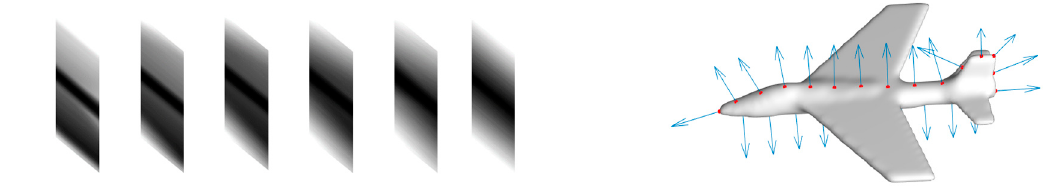
Figure 6. ( a ) Example of six consecutive frames of the tactile video captured from the model of Plane. (b) Example of sequence of normal